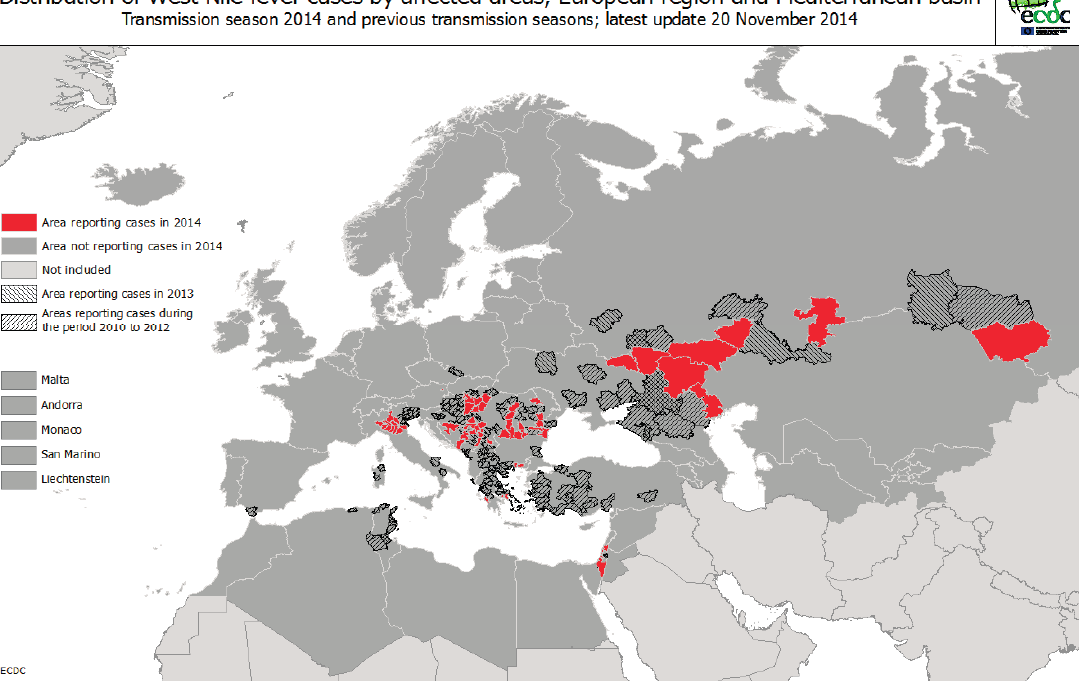
Figure 5. Distribution of WNF cases by affected areas, European region and Mediterranean basin, up to November 2014. Map reproduced with permission from ECDC 2014 ©